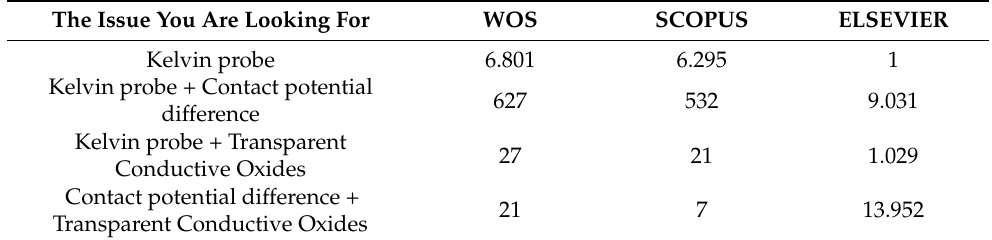
Table 2. List of published publications on general topics by three databases